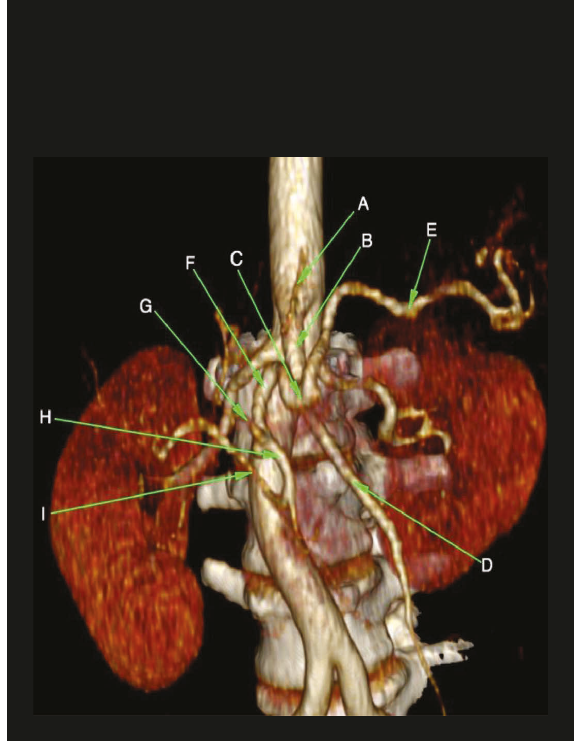
Figure 7: Three-dimensional volume rendering CT image dem- onstrating a hepato-spleno-mesenteric trunk. A � left gastric artery, B � celiacomesenteric trunk, C � celiac trunk, D � superior mes- enteric artery, E � splenic artery, F � common hepatic artery, G � left hepatic artery, H � gastroduodenal artery, and I � right hepatic artery (reproduced with permission from Johnson PB, et al. Vascular Supply to the Liver: Report of a Rare Arterial